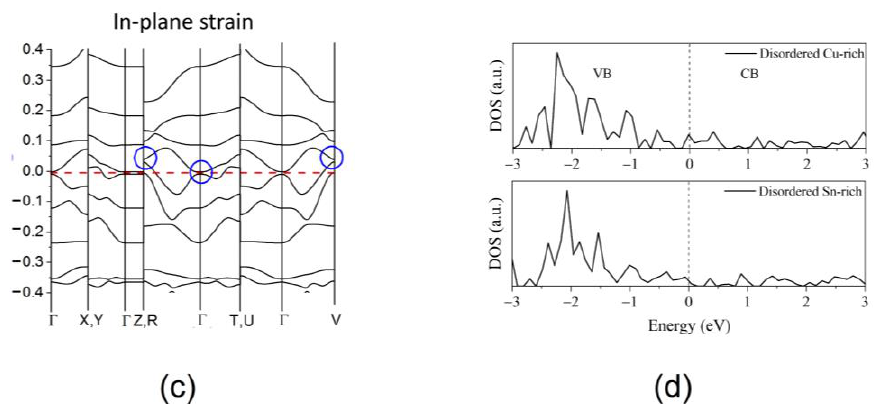
Figure 10. ( a ) Bulk band inversion and ( b ) topological surface states in pristine form and ( c ) under in-plane strain for disordered cubic CZTS; ( d ) surface DOS for disordered cubic CTS showing metal-like surface states. These band structure and density of states plots are taken from [56,74].